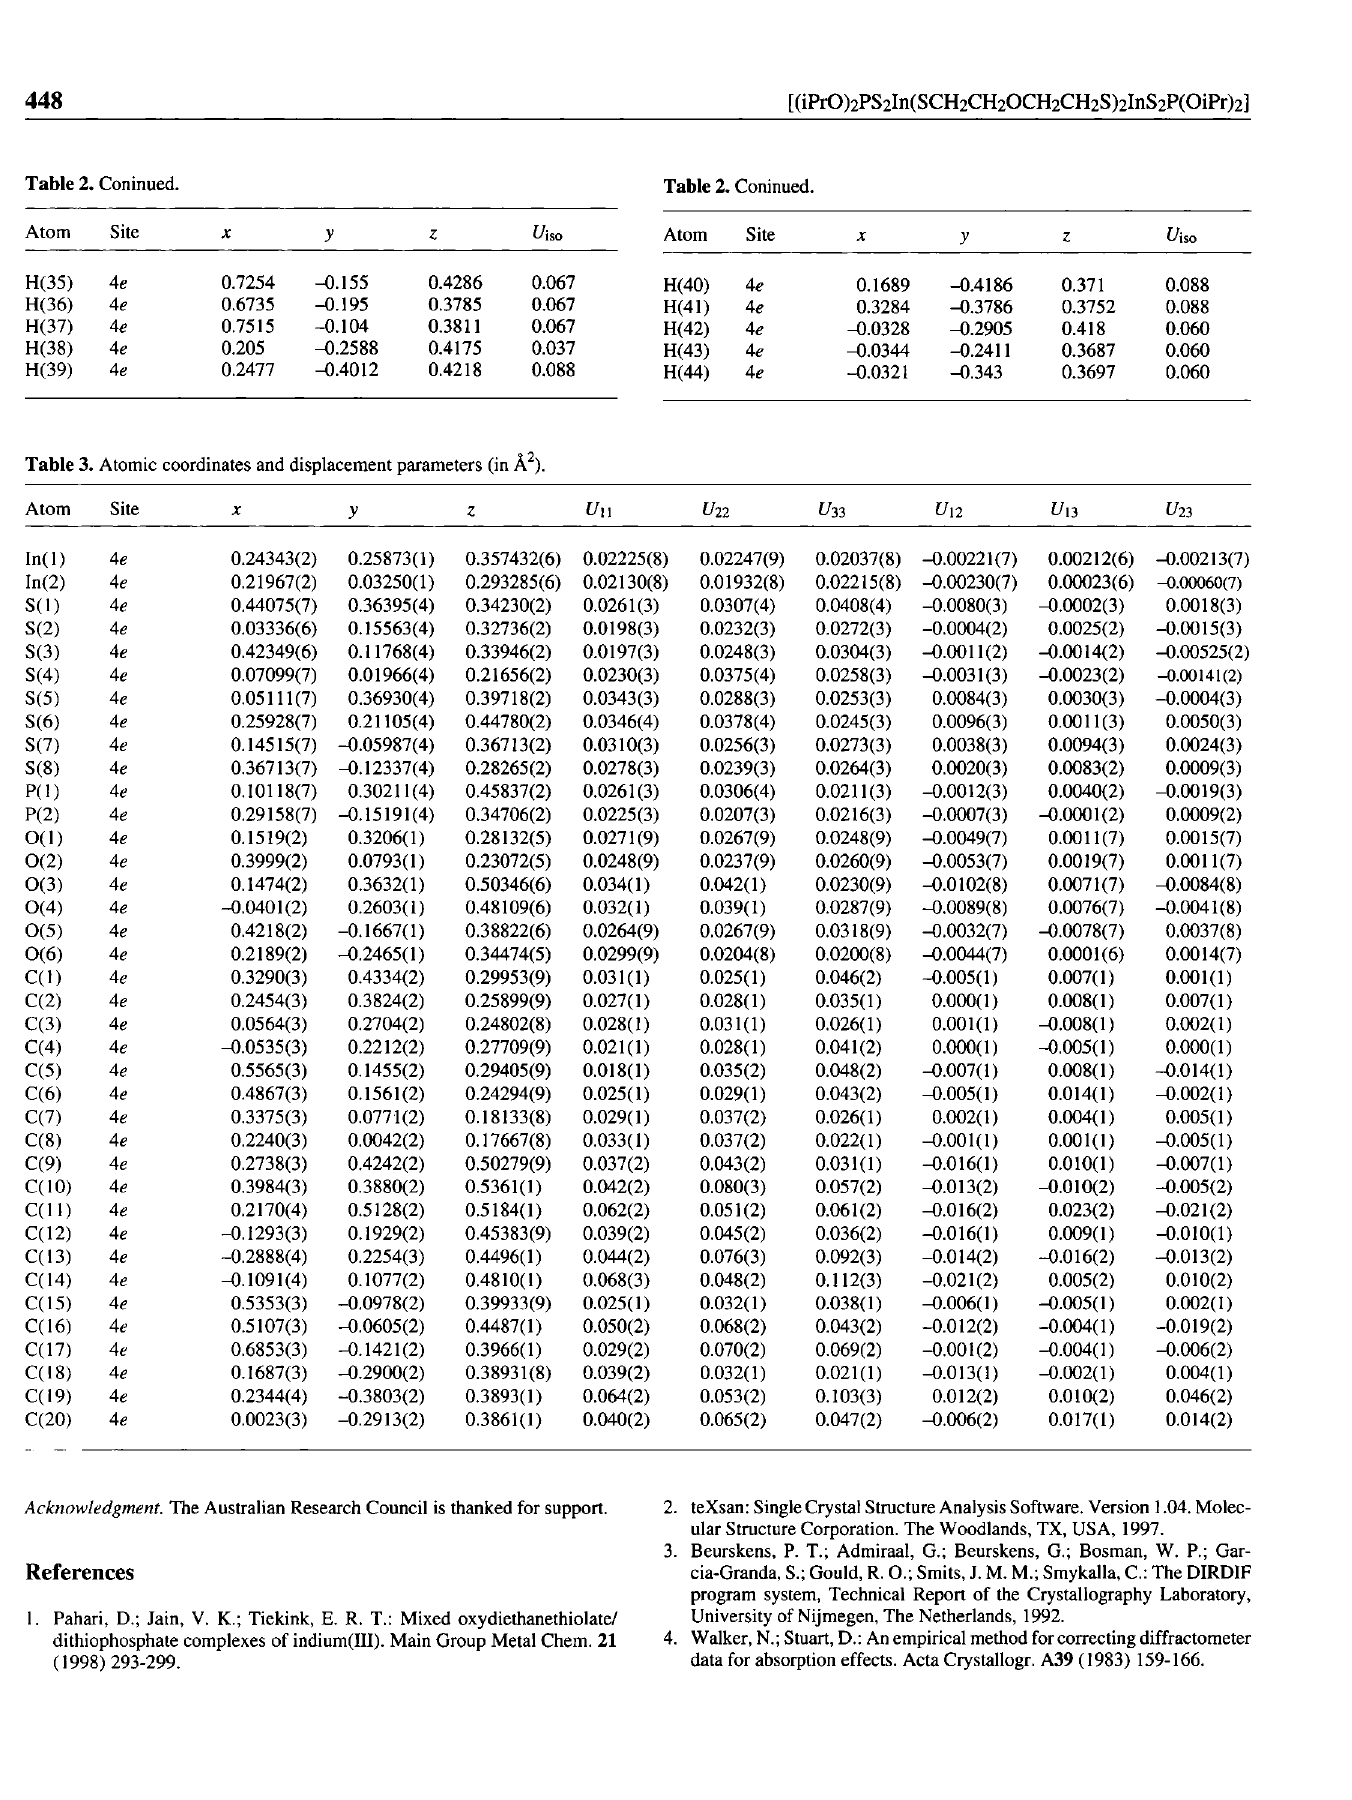
Table 2. Coninued.